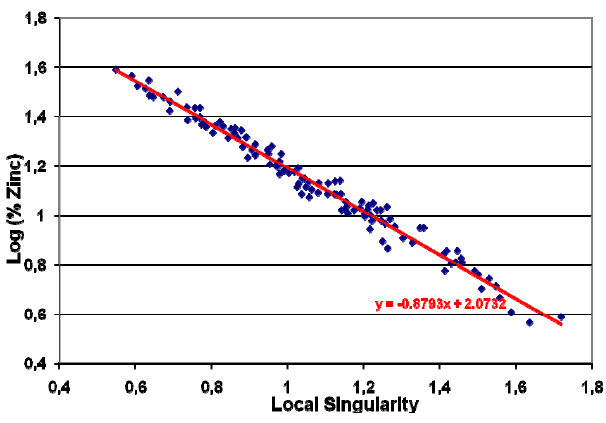
Fig. 22. Final singularity (black diamonds) plotted against log 10 (% Zn) is according to straight line (red) fitted by least squares.